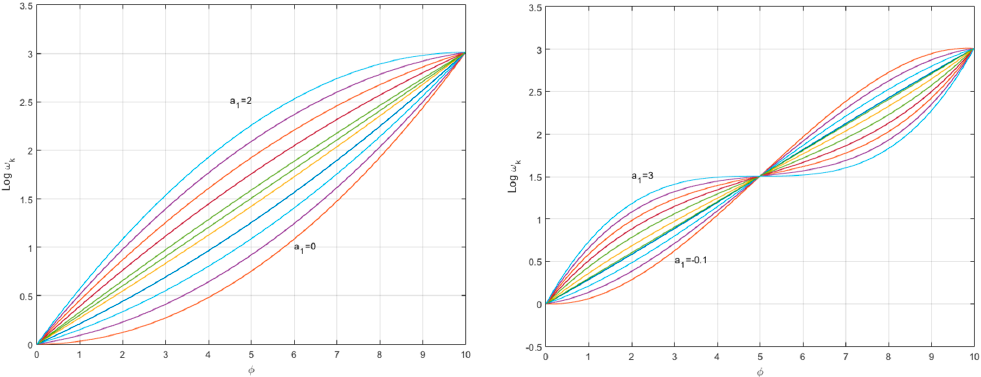
Figure 7. Two examples of pole distributions with D 3 : M = 2 ( left ), M = 3 ( right ).